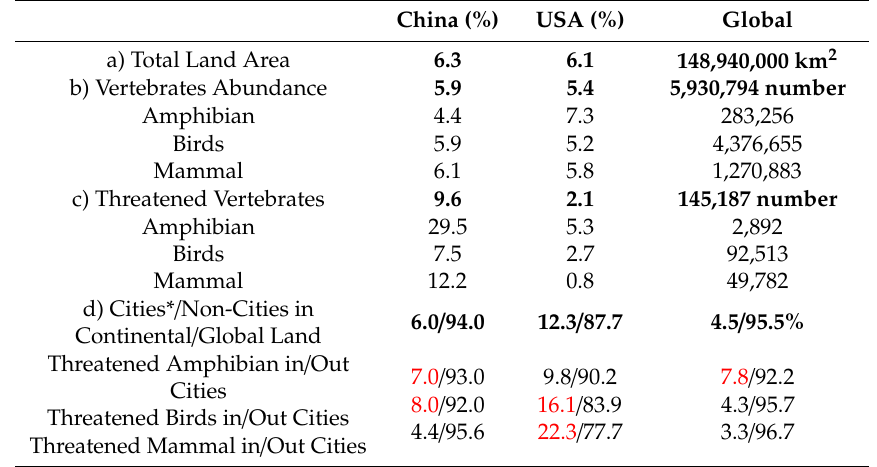
Table 1. Urbanization (representative year 2012) and vertebrates (representative year 2010): China and America (USA) compared with the globe in percentage of ( a ) area coverage, ( b ) vertebrate abundance and ( c ) threatened vertebrates, and ( d ) relative city nighttime lighted area and the percentage of threatened species inside China, America and the